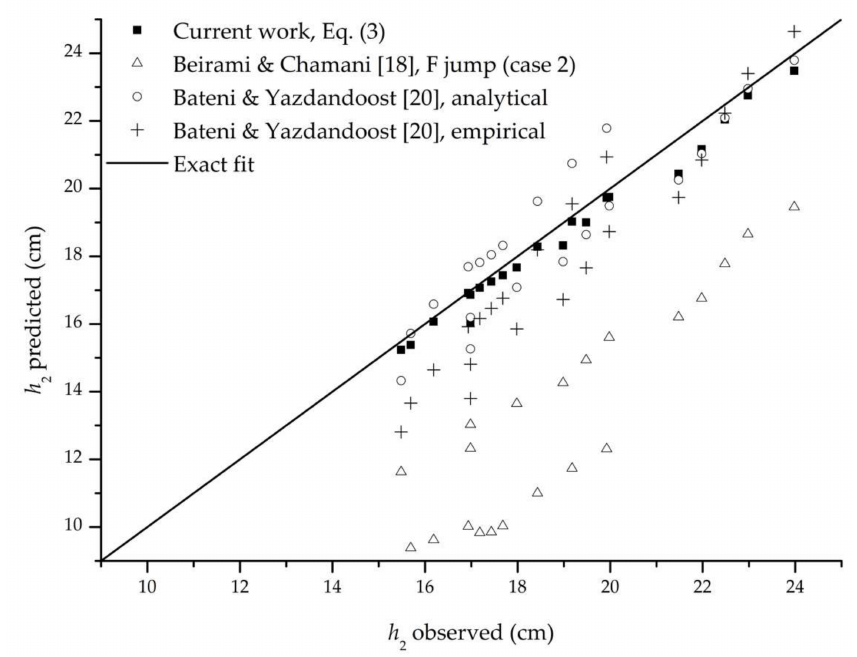
Figure 10. Comparison of different methods for predicting downstream depth h 2 for F jumps.